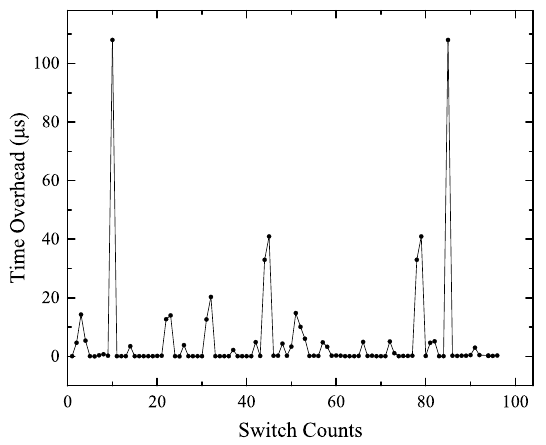
Figure 2. Context switch time overhead of